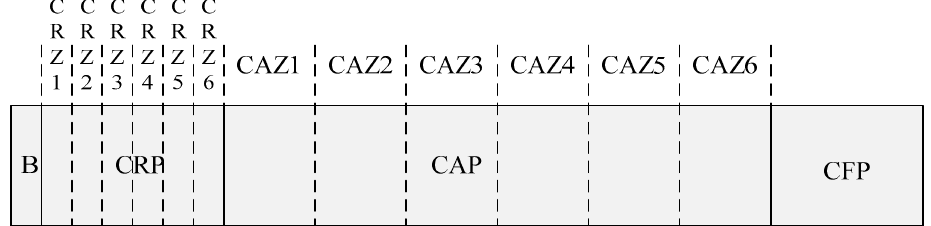
Figure 3. The superframe structure of the proposed scheme.